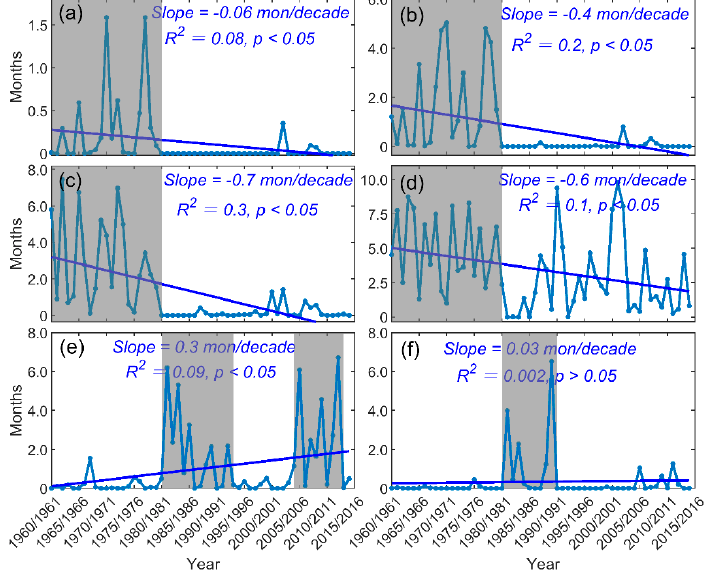
Figure 7. Changes in frequency of drought and wetness events of different magnitudes in SRYRB during 1960–2015 on the annual scale. ( a ) Extreme drought, ( b ) severe drought, ( c ) moderate drought, ( d ) mild drought, ( e ) moderate wetness and ( f ) severe and extreme wetness.